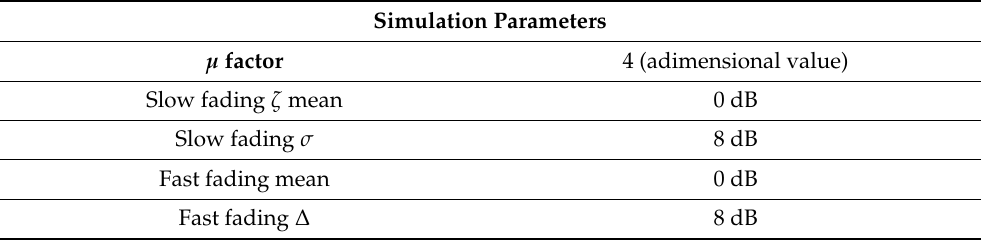
Table 1. Simulation parameters considered for an urban zone [13–15].